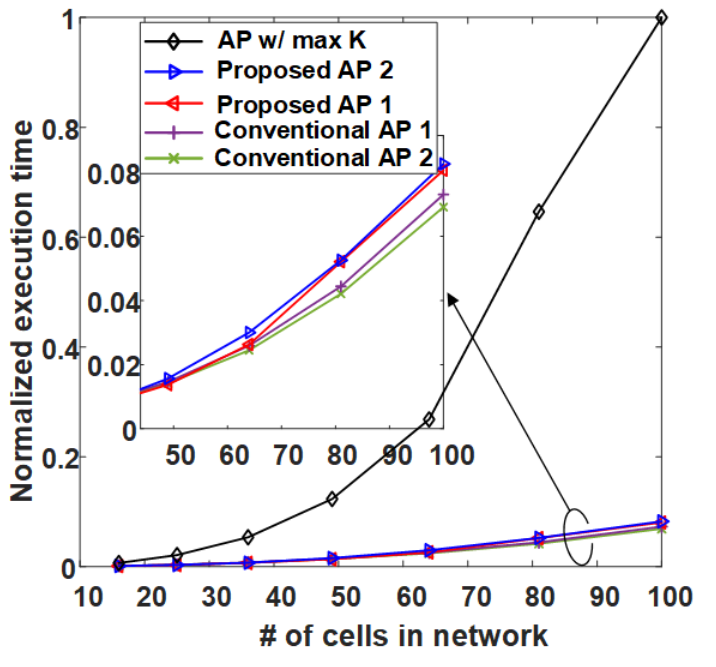
Figure 13. Average normalized execution time comparison of the conventional and the proposed clustering algorithms.